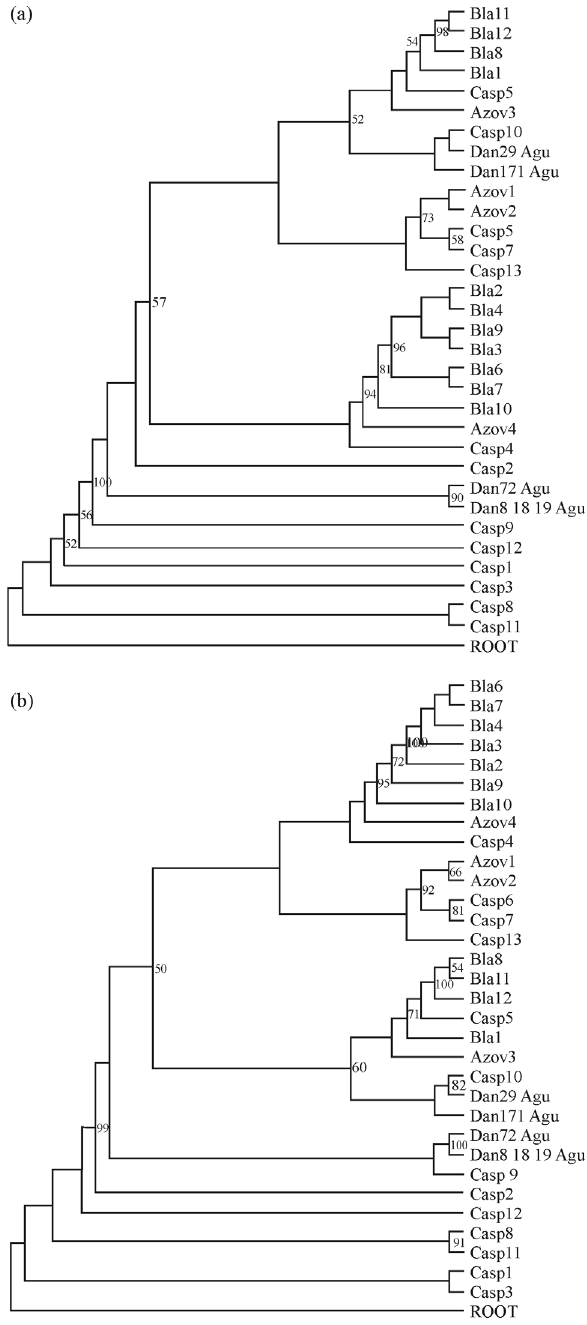
Figure 2 - Molecular phylogenetic trees inferred by partial D-loop se- quences analysis by Neighbor-Joining (A) and Maximum Likelihood (B) in A. gueldenstaedtii constructed using the Tamura3 parameter plus G model with 1000 bootstrap iterations. ROOT indicates the outgroup spe- cies A. baerii (NC_017603). The numbers represent the confidence boot- strap values higher than 50. Bla= Black Sea; Casp = Caspian Sea; Azov = Azov